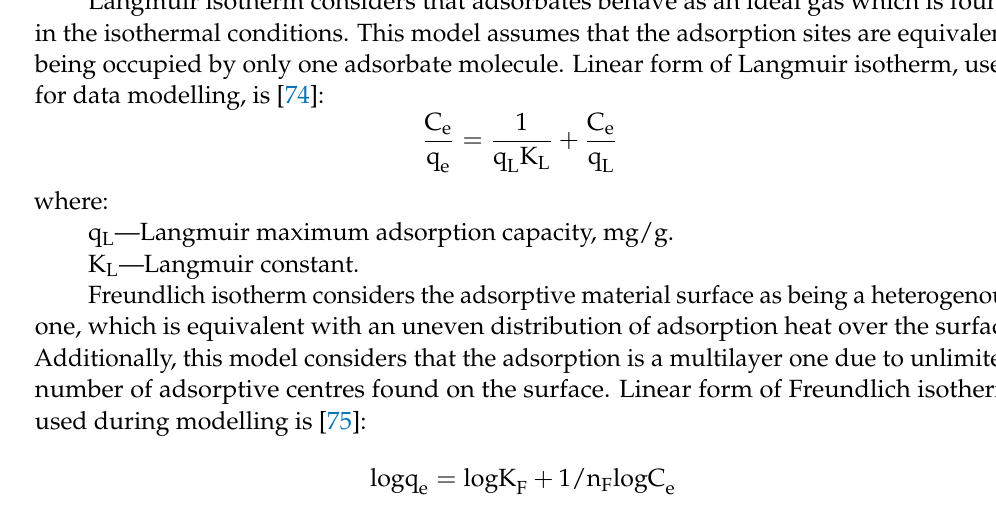
Table 6. Isotherm parameters obtained based on adsorption isotherm.